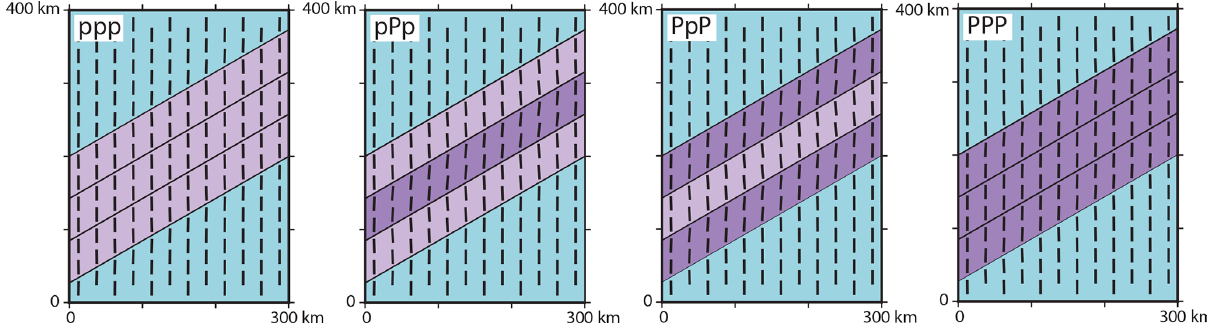
Figure 7. Influence of Poisson’s ratio on the stress orientation. Black bars represent the orientation of S Hmax at a depth of 1000m. Colours indicate the material properties used. The blue area uses the reference material properties ( ν = 0 . 25), the light purple area is characterized by a low Poisson’s ratio (p: ν = 0 . 15) and the dark purple one by a large Poisson’s ratio (P: ν = 0 . 35).